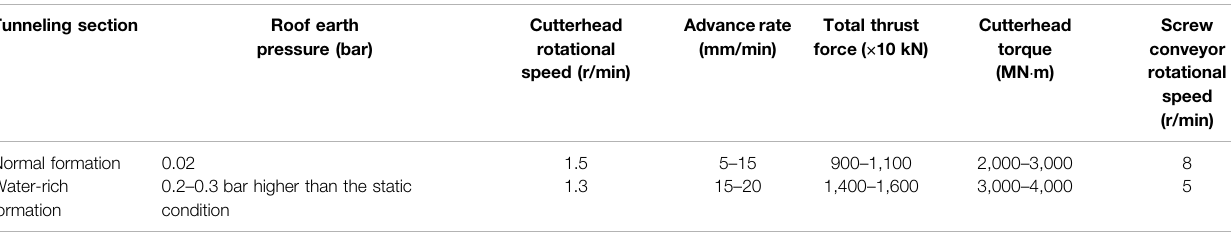
TABLE 2 | Optimal tunneling parameters in the karst and fi ssure water-bearing limestone section. Tunneling